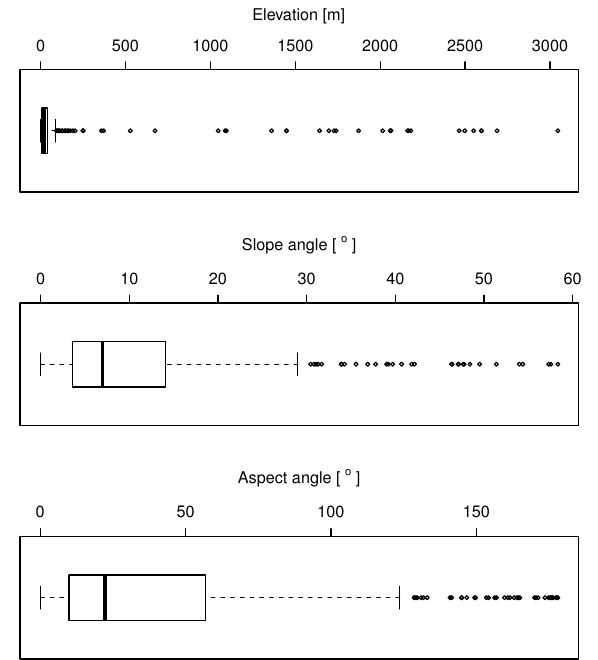
Fig. 3. Absolute difference between terrain variables calculated based on ASTER GDEM and the ones provided by the data con- tributor into the permafrost evidence collection (Cremonese et al.,